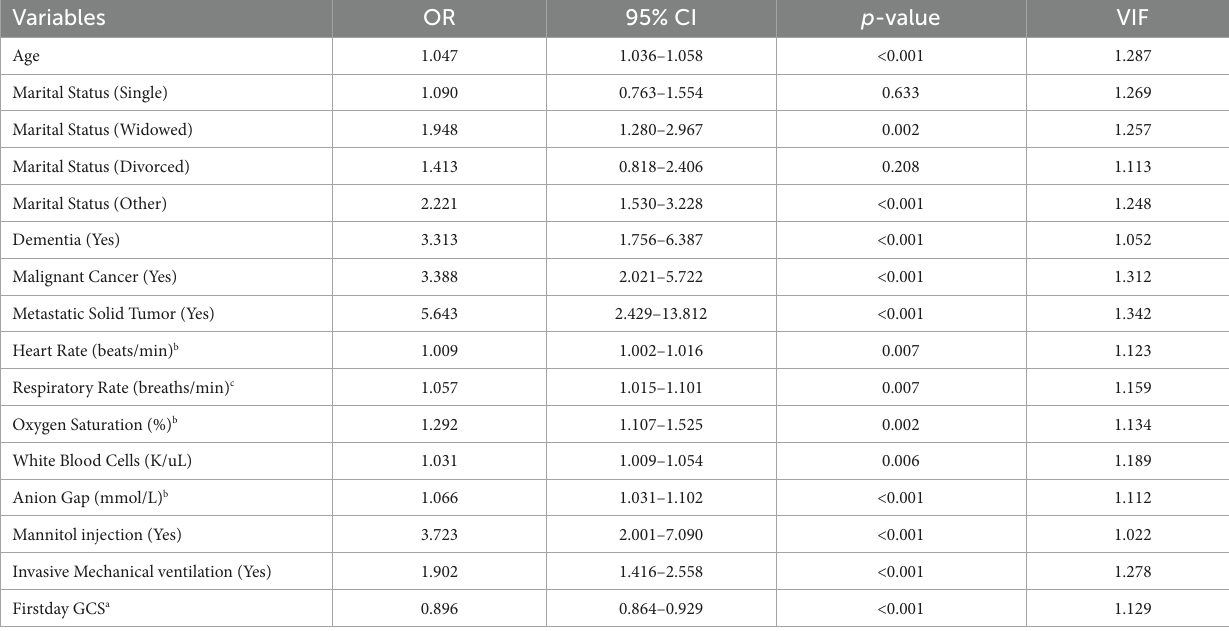
TABLE 2 Multivariable logistic regression analyses of independent risk factors of the 1-year mortality in patients with ischemic stroke in the developing cohort.